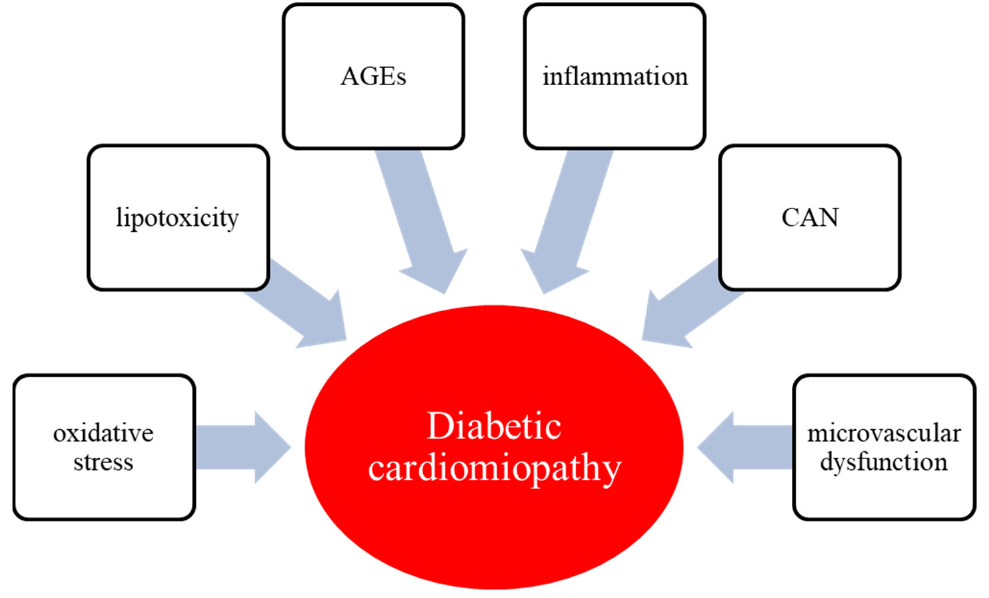
Figure 1. Molecular mechanisms underlying the development and progression of DC. AGEs, advanced glycated end-products; CAN, cardiac autonomic neuropathy.